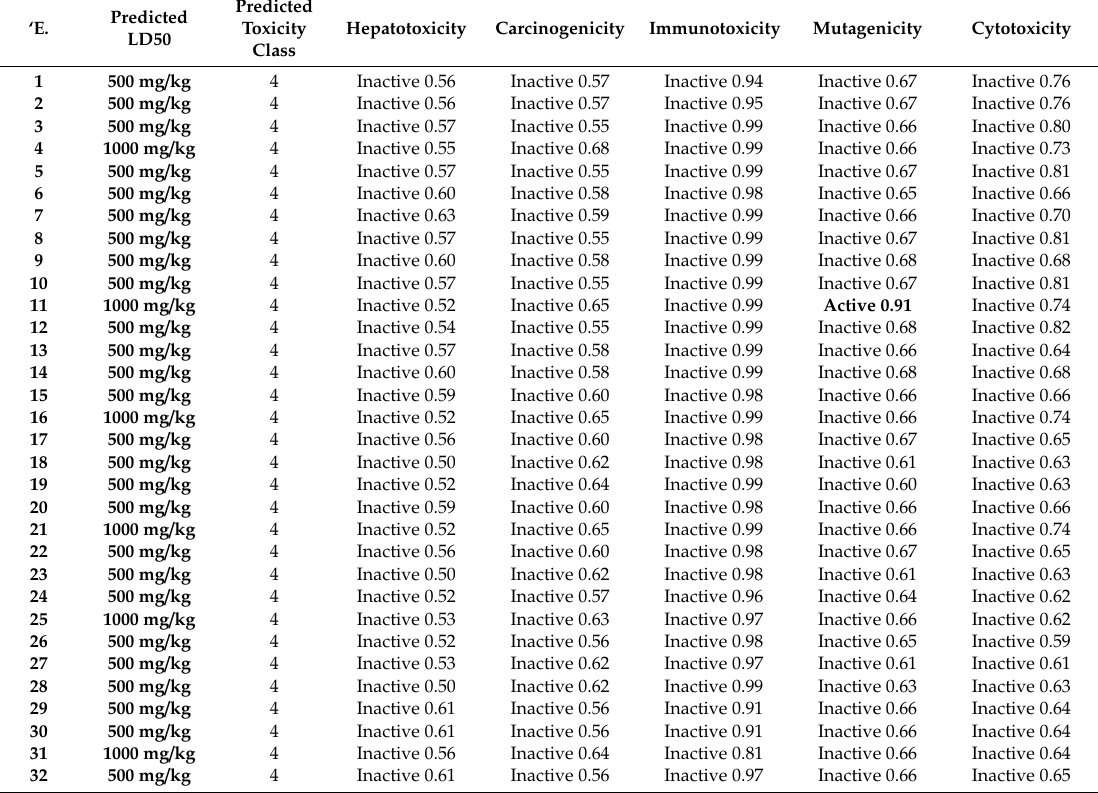
Table 3. Predicted toxicity with program